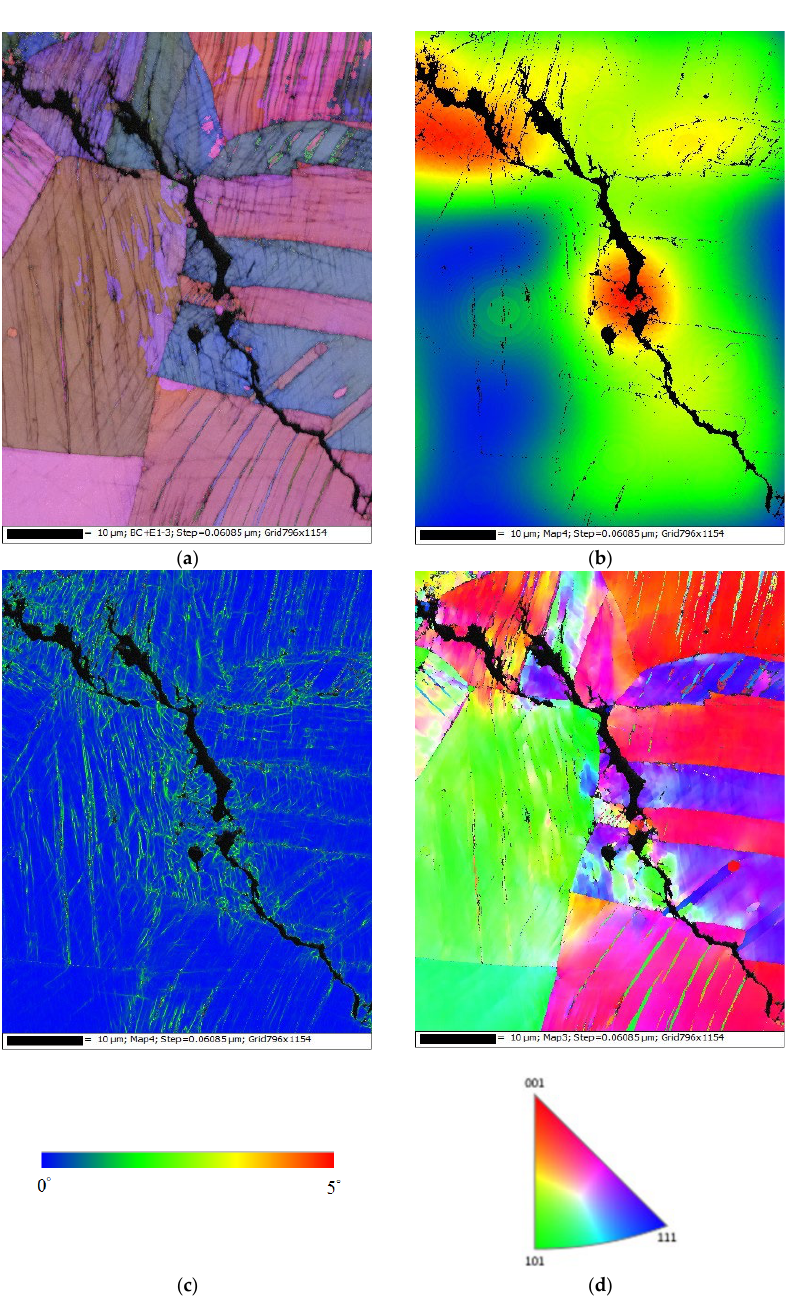
Figure 13. Electron back scatter diffraction (EBSD) maps for the crack region of the specimens deposited with a 1 g/m 2 chloride concentration tested for 7000 h at 70% RH : ( a ) Euler map, ( b ) strain countering map, ( c ) kernel average misorientation (KAM) map, and ( d ) inverse pole figure (IPF) map.